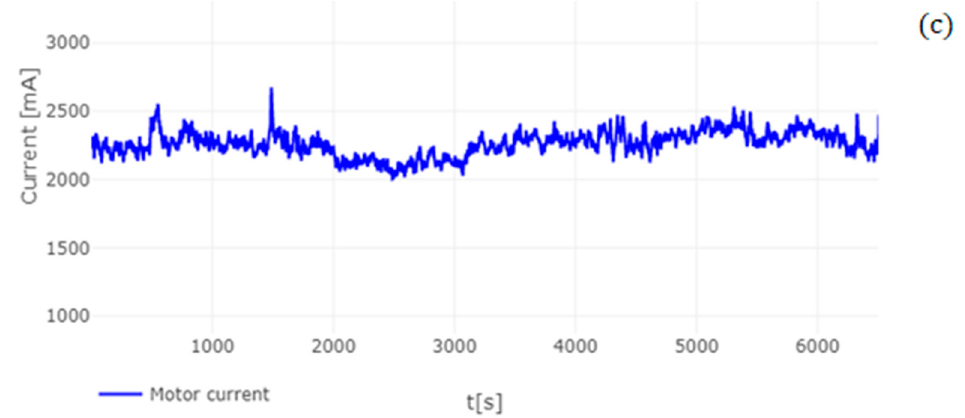
Figure 7. Analysis of filament produced ( a ), Measurement of the diameter of the filament; ( b ), measurement of RPM Filament Maker ( c ) Measurements of current on Filament Maker